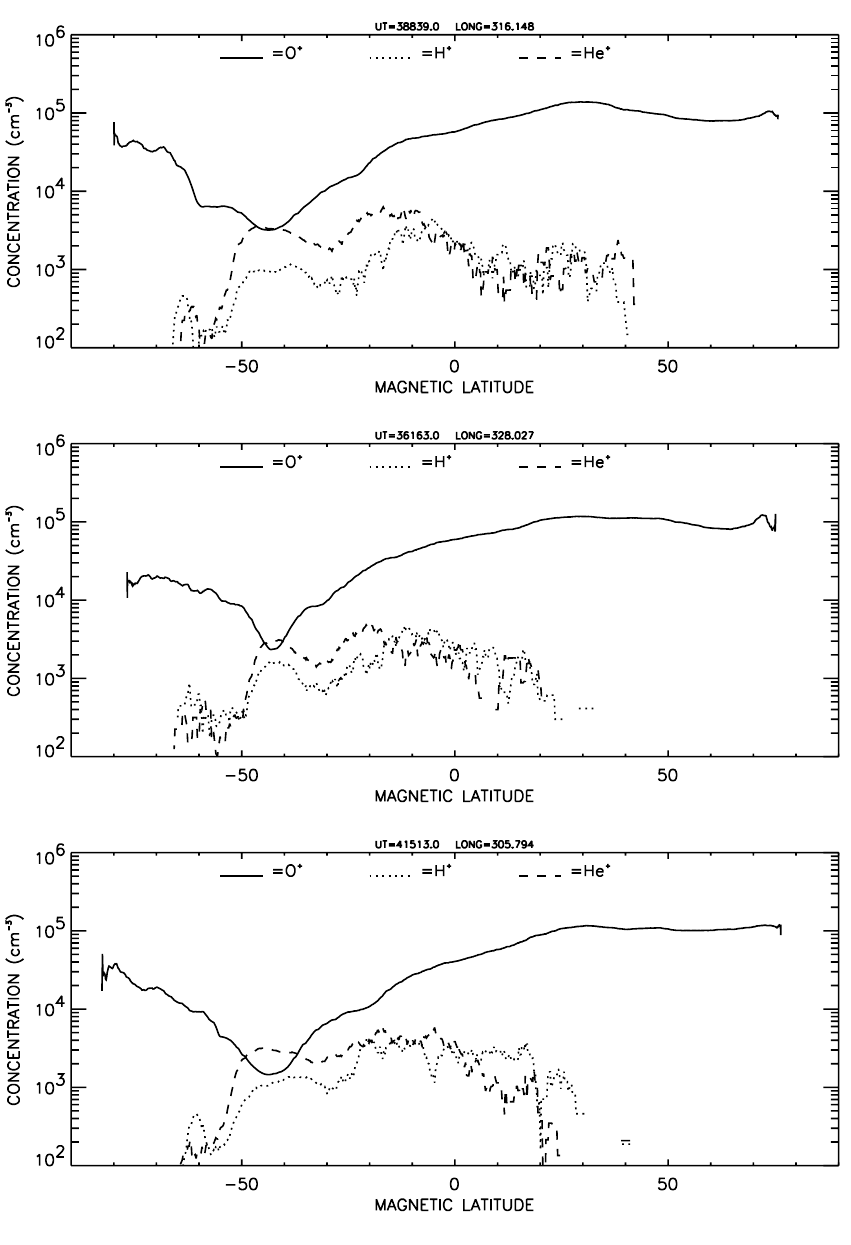
Fig. 5. Examples of periods when the He + ion is dominant, or comparable with the O + ion in the trough region. These plots show data from the pe- riod when the plasmasphere is either disturbed, or recovering from disturbed conditions (4, 22, and 29 June, respec- tively). Such examples are typical of He + dominance in the trough region which occurs during the recovery pe- riod throughout the month of